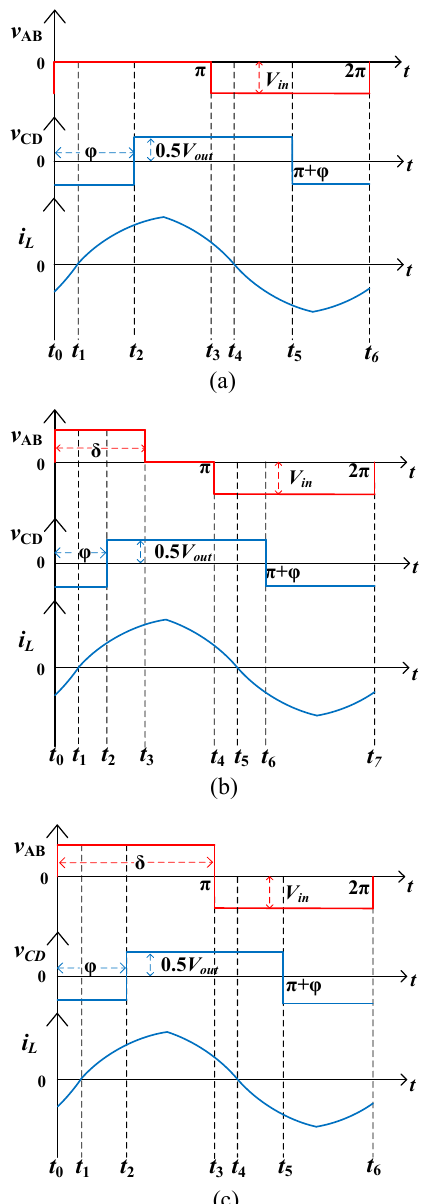
Figure 9. Typical waveforms at different voltage gains: ( a ) M = 0.5; ( b ) M = 0.6; ( c ) M = 1.